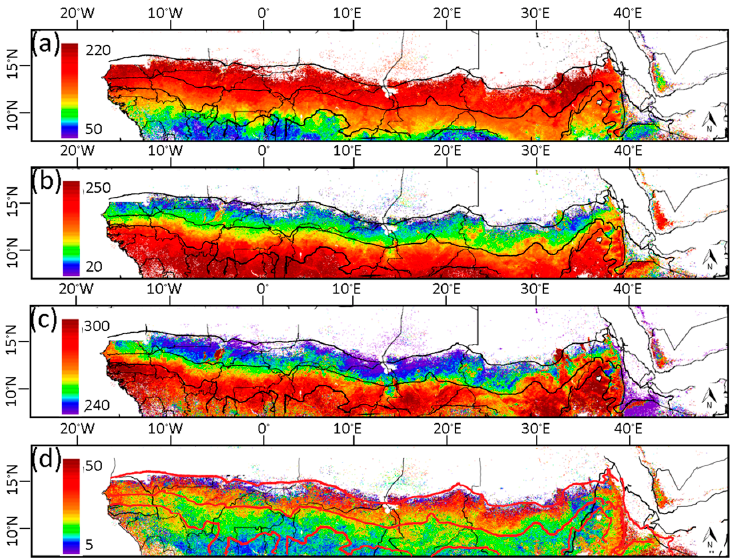
Figure 3. Spatial variation in averaged values (1982–2006), of ( a ) greenup “onset of greenness increase”, ( b ) senescence “onset of greenness decrease”, and ( c ) length of growing season (days). The map in ( d ) is the between-year variation (±2 standard deviations) in the onset date of greenness increase. The red lines (black in ( d )) from north to south are the 300 mm, 700 mm and 1100 mm rainfall isohyets.